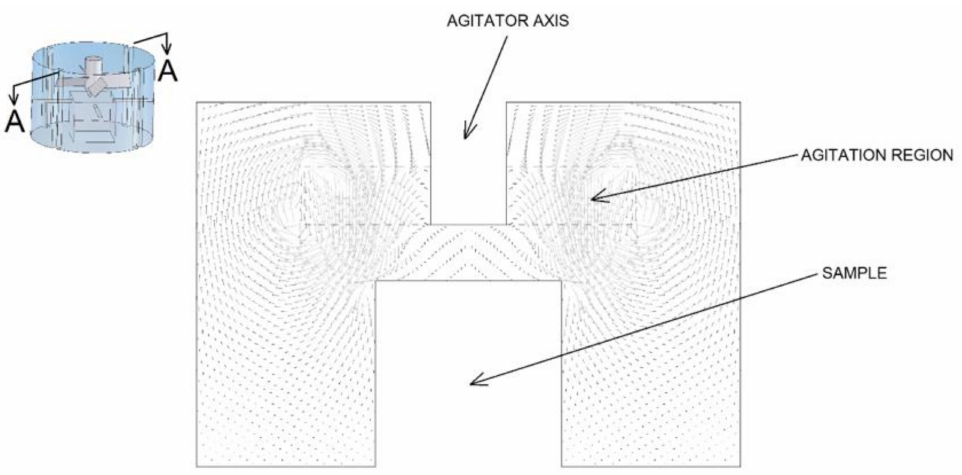
Figure 7. Velocity field in the A-A middle